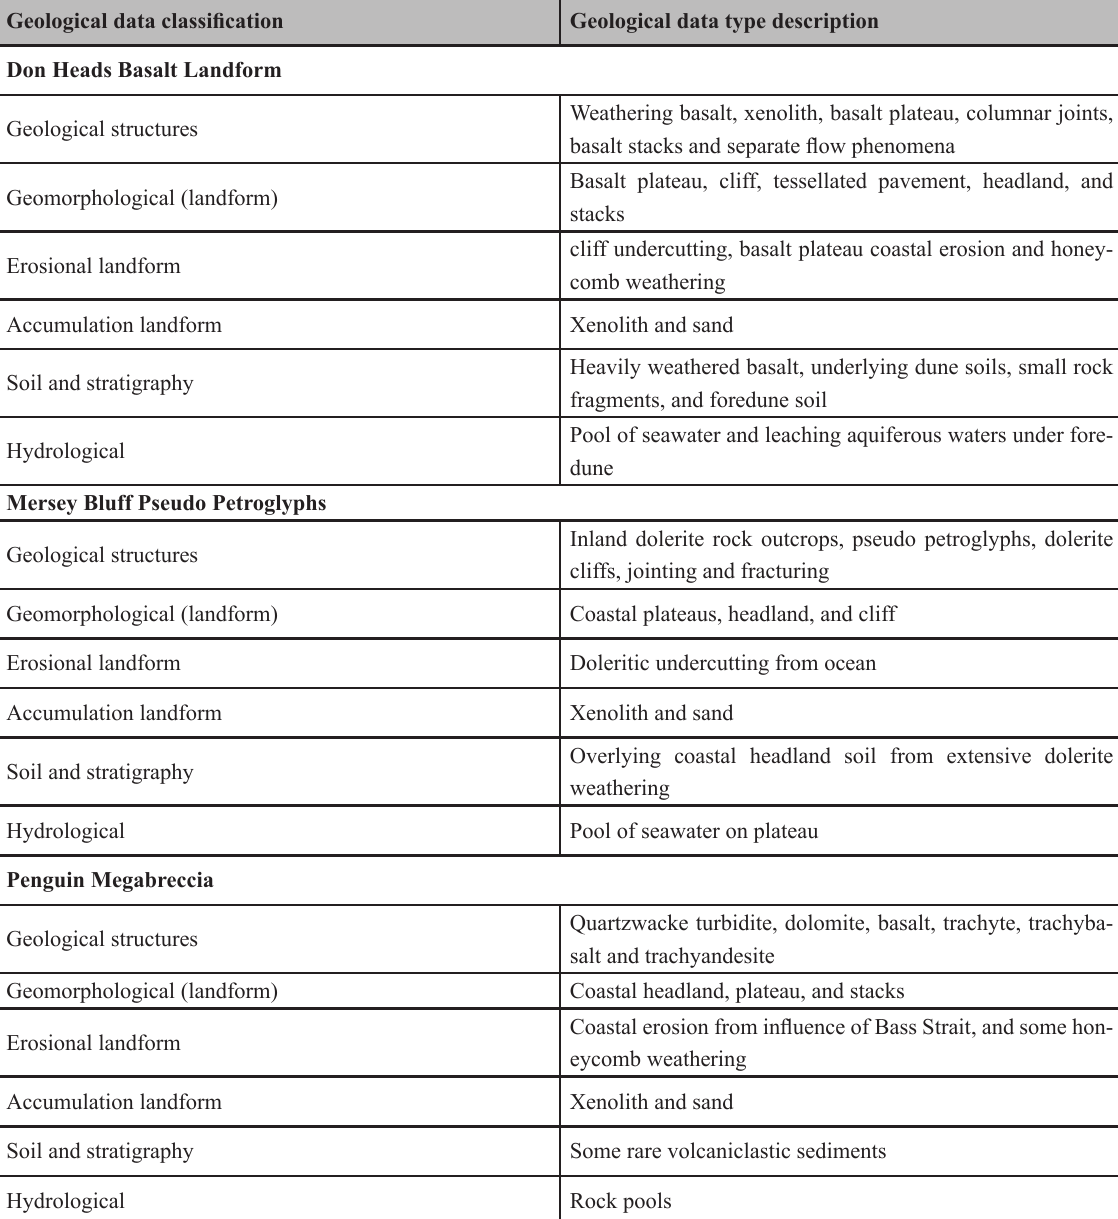
Table 5 . A summary of geological data types captured at each geoconservation site from within the established geological data classifications used to capture geodiversity in ArcGIS